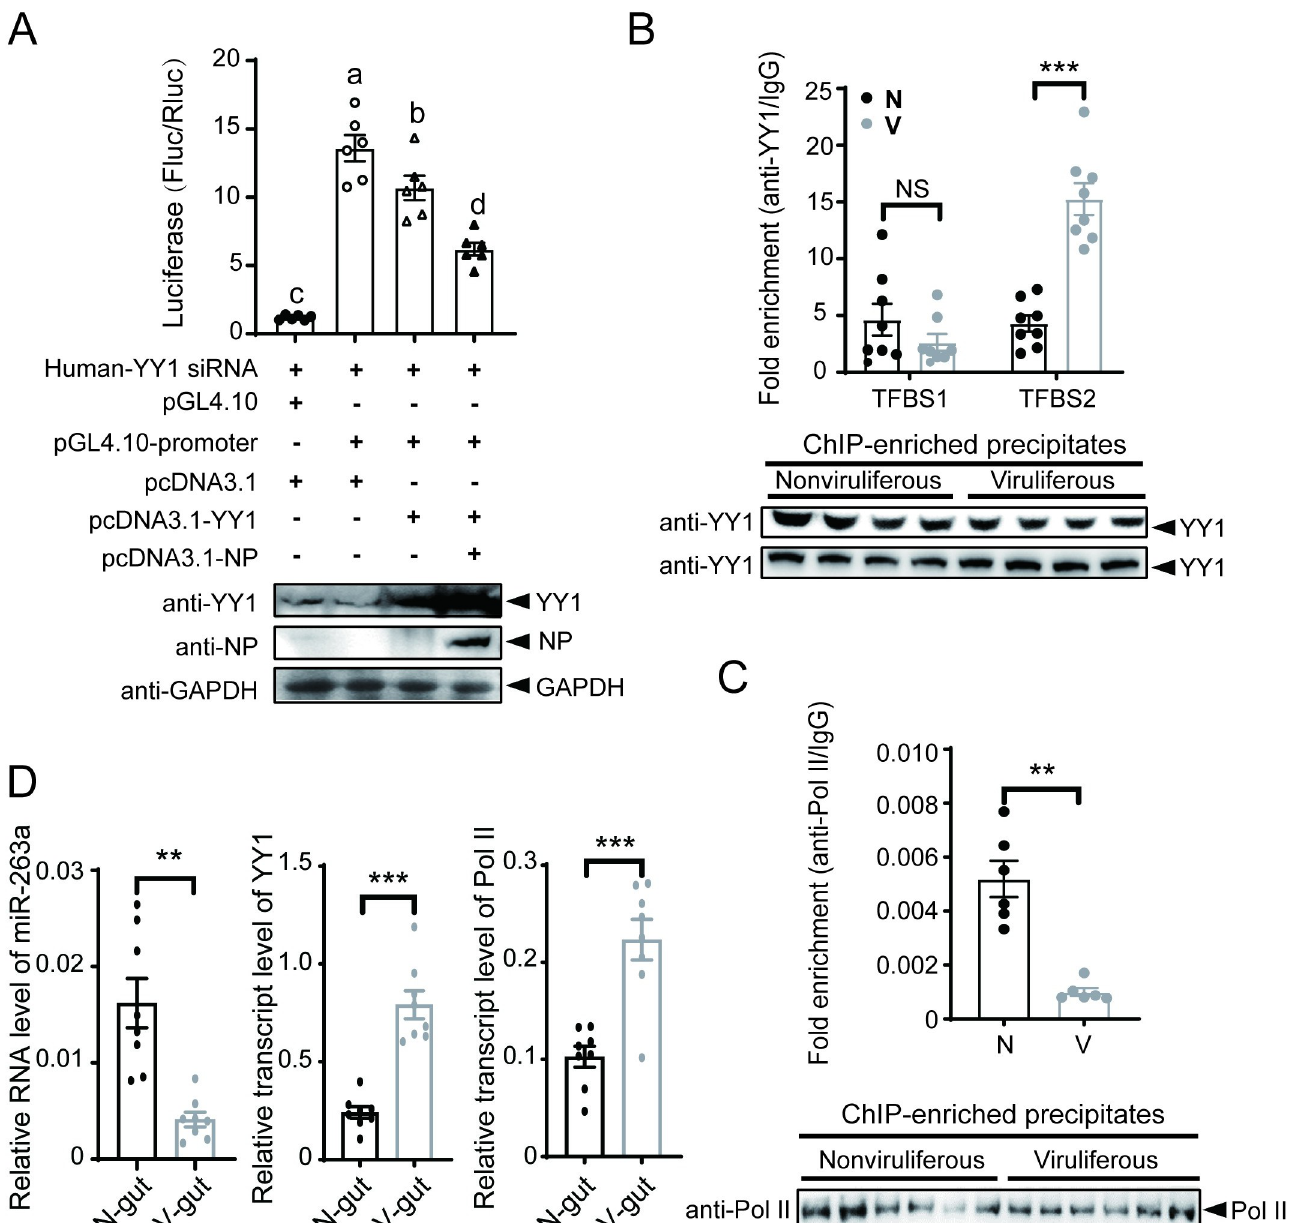
Fig 3. Binding with RSV NP promotes the inhibitory effect of YY1 on miR-263a transcription. (A) Dual luciferase reporter assay on the promoter activity of miR-263a after expression of planthopper YY1 or both YY1 and RSV NP in 293T cells with the addition of siYY1. The relative activity of firefly luciferase (Fluc) to Renilla luciferase (Rluc) is presented. Empty pGL4.10 and pcDNA3.1 were used in the negative control groups. Western blot assays show the protein expression. Different letters indicate significant differences in Tukey’s multiple comparison test. (B) Enrichment of YY1 binding sites TFBS1 and TFBS2 precipitated by the anti-YY1 polyclonal antibody relative to that precipitated by IgG in nonviruliferous (N) and viruliferous (V) planthoppers measured by ChIP-qPCR (n = 8). Comparable amounts of YY1 in the two groups were detected by western blot. (C) Enrichment of the putative RNA polymerase II (Pol II) binding sequence precipitated by the anti-Pol II monoclonal antibody relative to that precipitated by IgG in N and V planthoppers measured by ChIP-qPCR (n = 6). Comparable amounts of Pol II in the two groups were detected by western blot. (D) Relative transcript levels of miR-263a, YY1 and Pol II in the guts of nonviruliferous and viruliferous planthoppers. Data information: Graphs show mean values and standard errors. NS, no significant difference. �� , P < 0.01. ��� , P < 0.001.